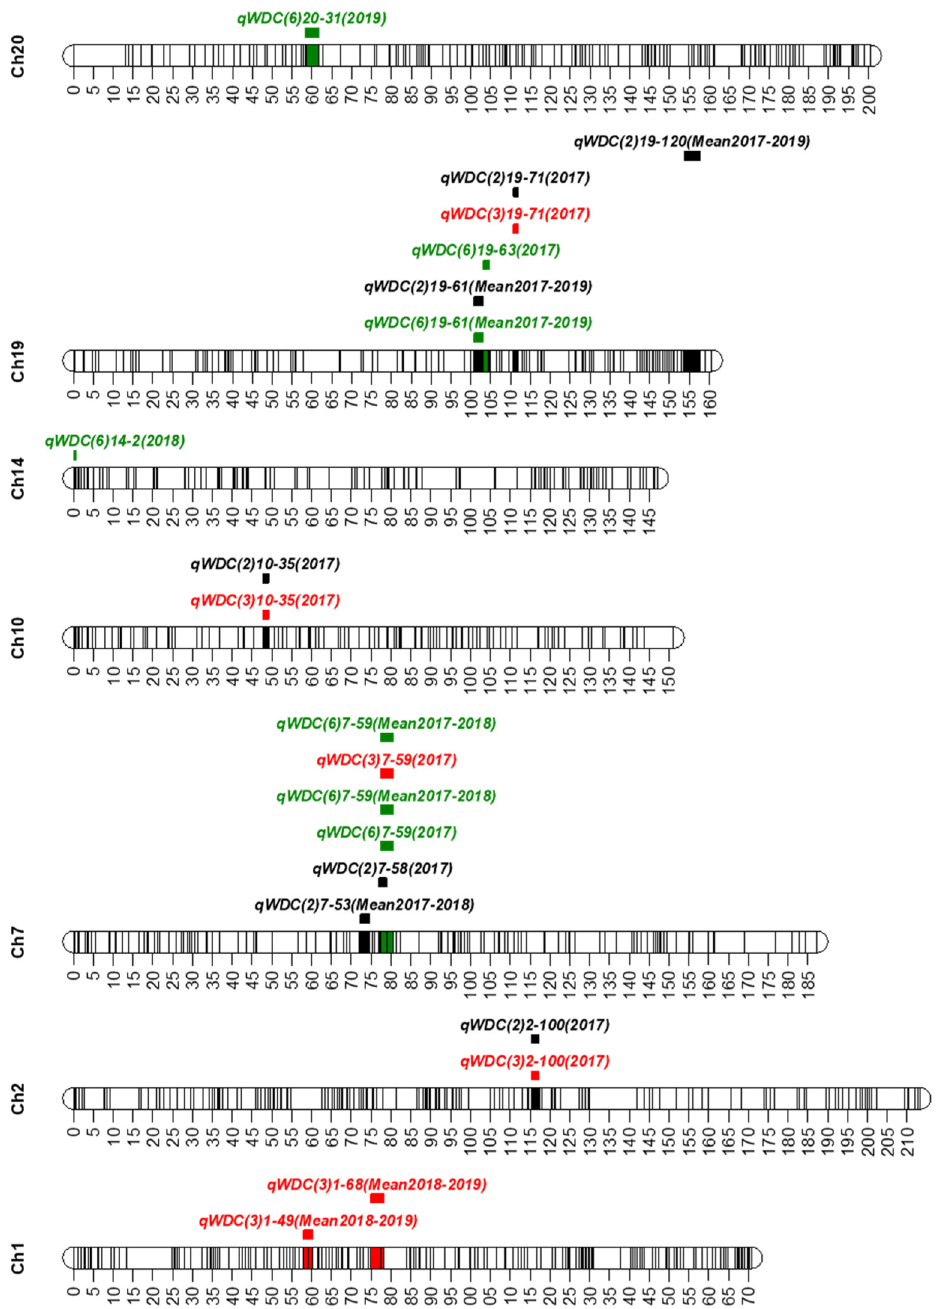
Figure 2. Positions of the QTLs for drought tolerance on seven chromosomes (Ch). q: QTL, WDC: weighted drought coefficient. In the QTL names, the first number in the parentheses after WDC represents the number of traits considered to calculate WDC (black, red, and green for 2, 3, and 6 traits, respectively; the second number is for chromosome name; the number after a dash (-) represents the sequential number of the marker on the linkage map; and mean denotes the average value of the traits in different years (2017–2019). The lines inside the chromosomes represent the position of markers used to construct the linkage map. The colored bars indicate the QTL regions. The scaled numbers next to chromosomes indicate the genetic length (cM) of the chromosome.